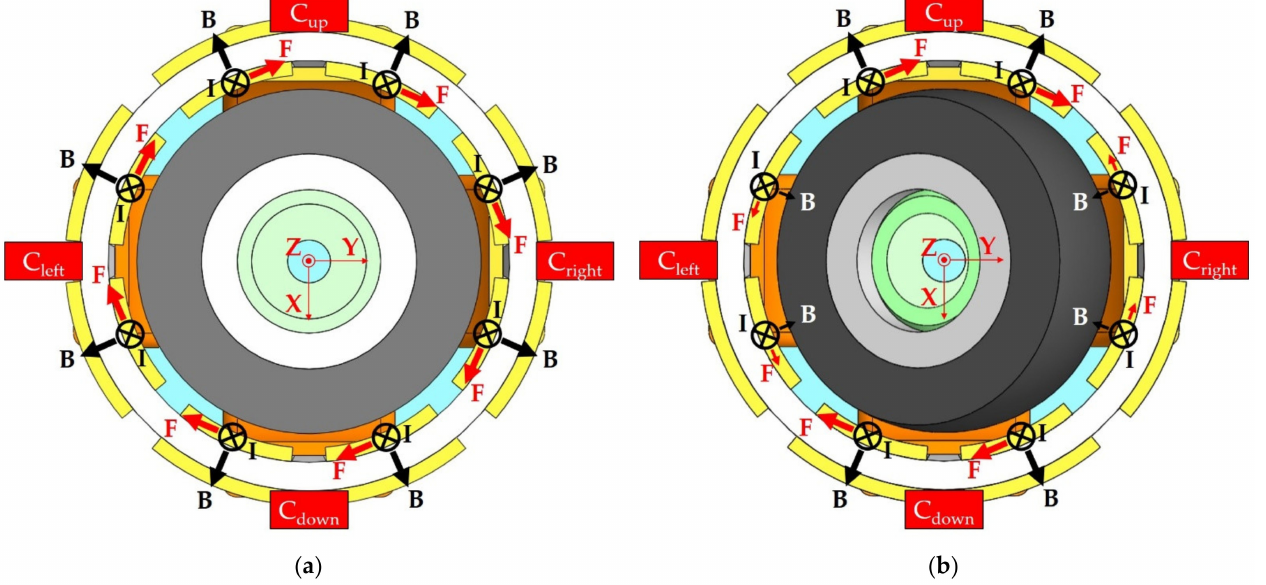
Figure 4. The operating principle for the rotation about the Z -axis when the rotor is tilted at ( a ) 0 ◦ and ( b ) 30 ◦ along the X